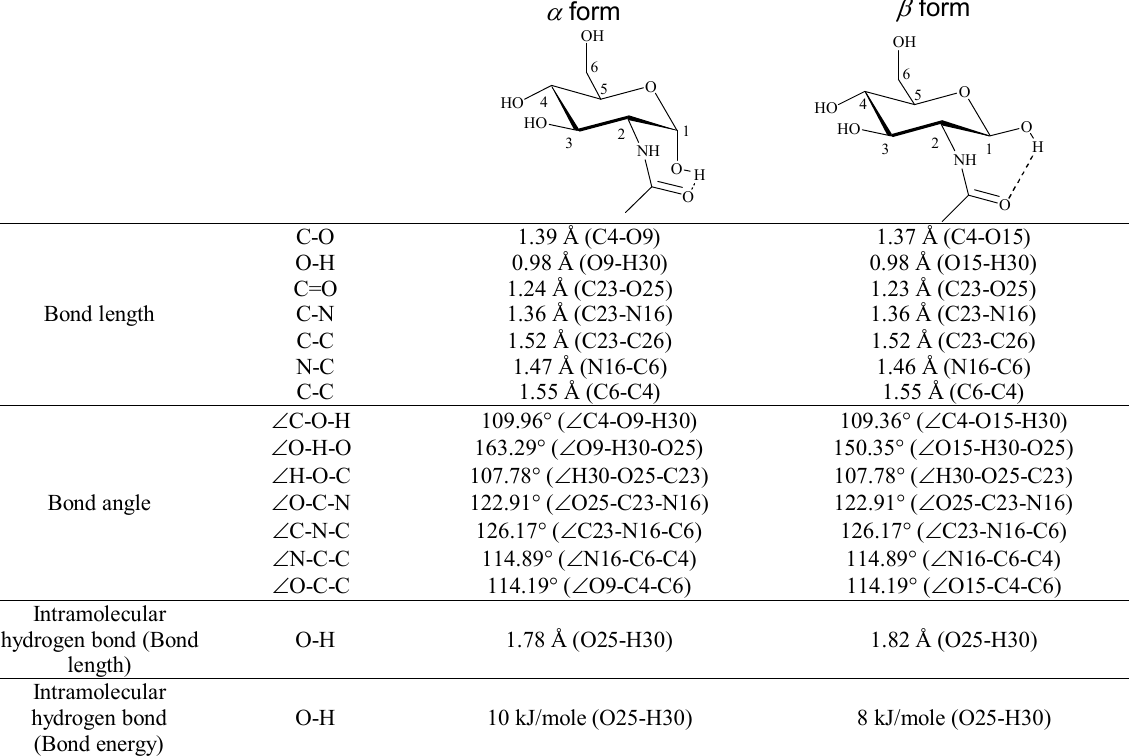
Table 7. The bond length and bond angle, bond energy of intramolecular hydrogen bond of α and β form (GlcNAc) performed with the Gaussian 03